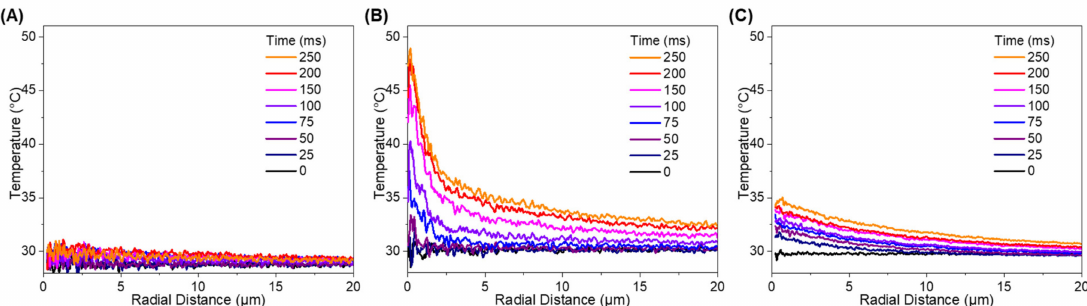
Figure 5. The time sequence of radial temperature profiles during laser irradiation. ( A ) The laser initially irradiated Al/THV/R6G film on a grating substrate with the absence of Al NP. Radial temperature profiles from the temperature maps of heated 120-nm Al NP supported on a ( B ) plasmonic grating and ( C ) flat silver substrates showing time-sequence before (at 0 ms) and during laser-induced heating.